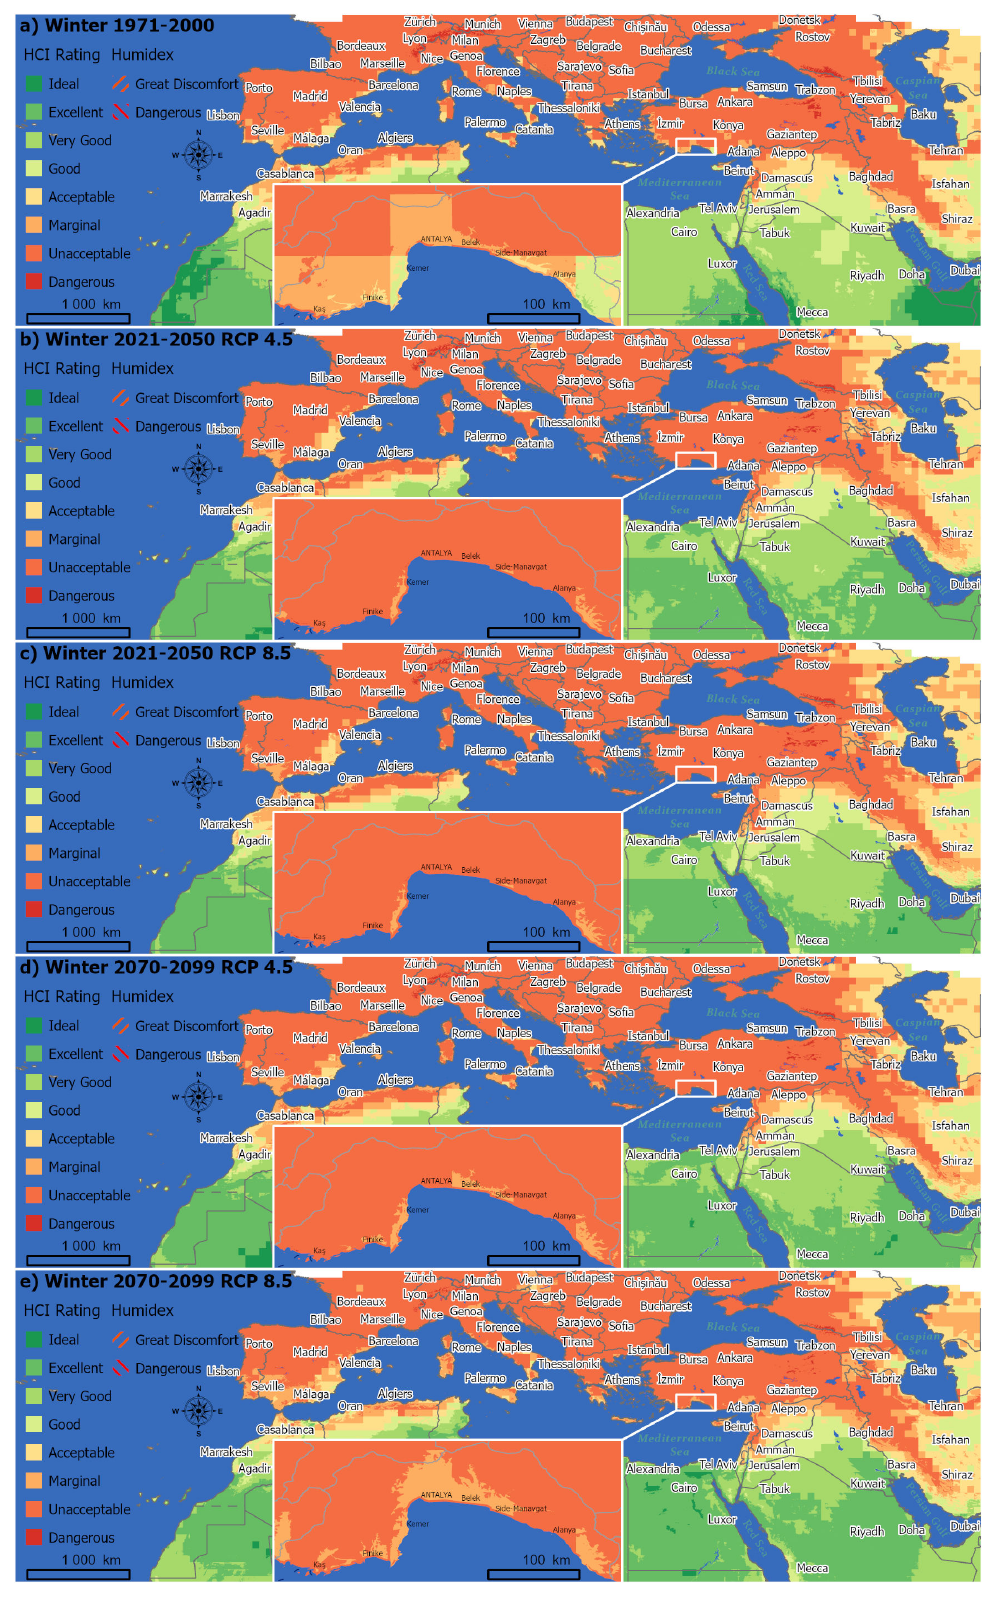
Figure 4. Winter season Holiday Climate Index (HCI) ratings and Humidex risks in the greater Mediterranean region for the projection periods ( a ) 1971–2000 ( b ) 2021–2050 (RCP 4.5) ( c ) 2021–2050 (RCP 8.5) ( d ) 2070–2099 (RCP 4.5) ( e ) 2070–2099 (RCP 8.5). Please note that a Humidex risk was not detected for any of the